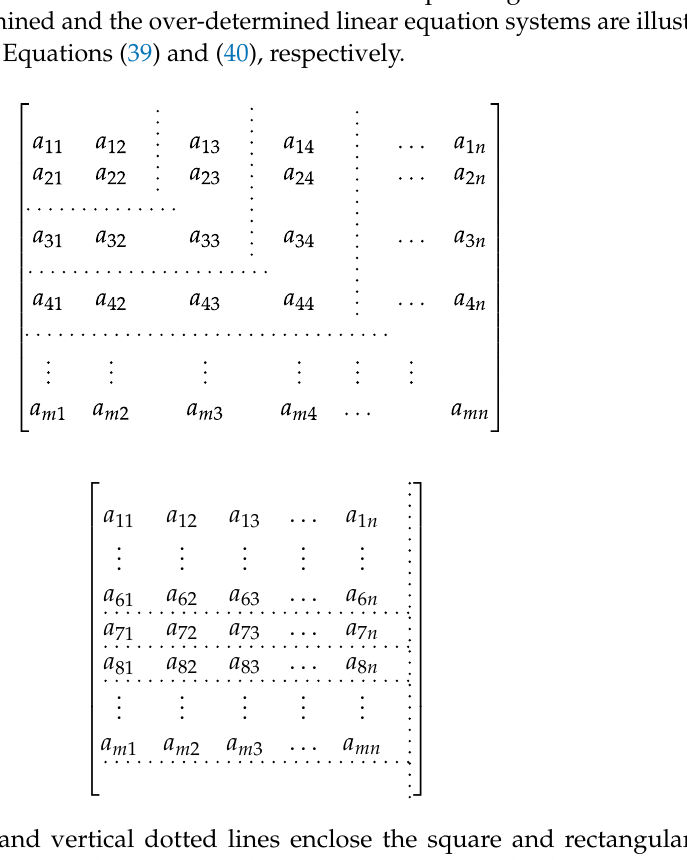
Table 2: Complexity of the algorithms evaluated.